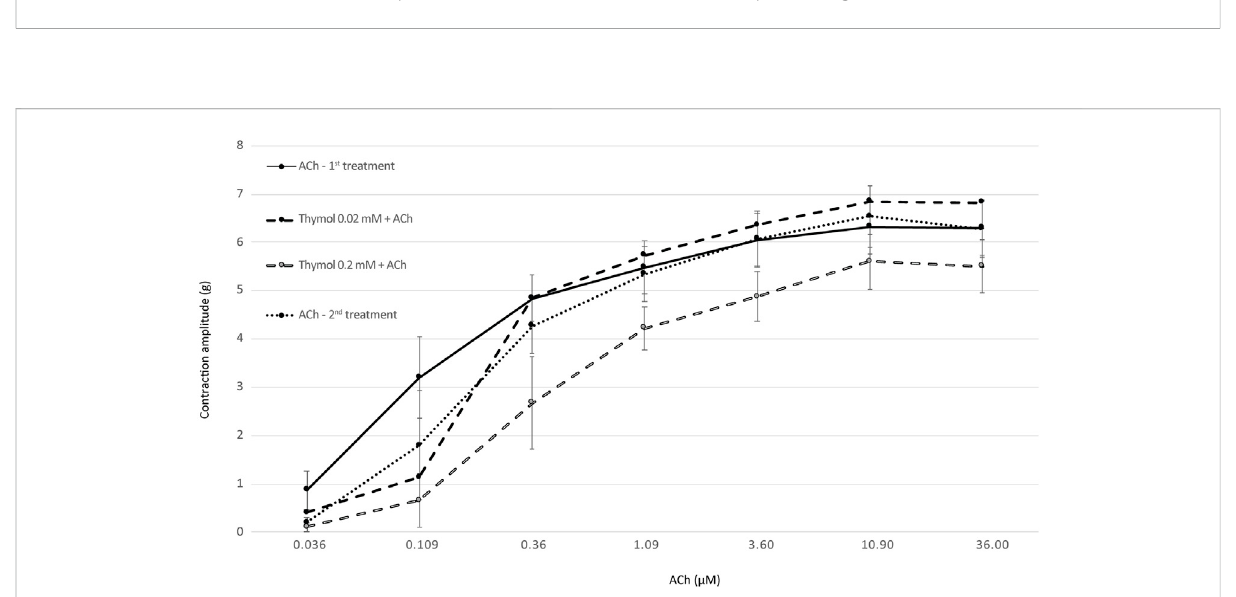
FIGURE 2 The intensity of uterine horn contraction induced with increasing doses of ACh ( fi rst and second control) and the combination of thymol (0.02 and 0.2 mM) and ACh ( N = 10). The results are expressed as the mean ± SE of contraction amplitude (in